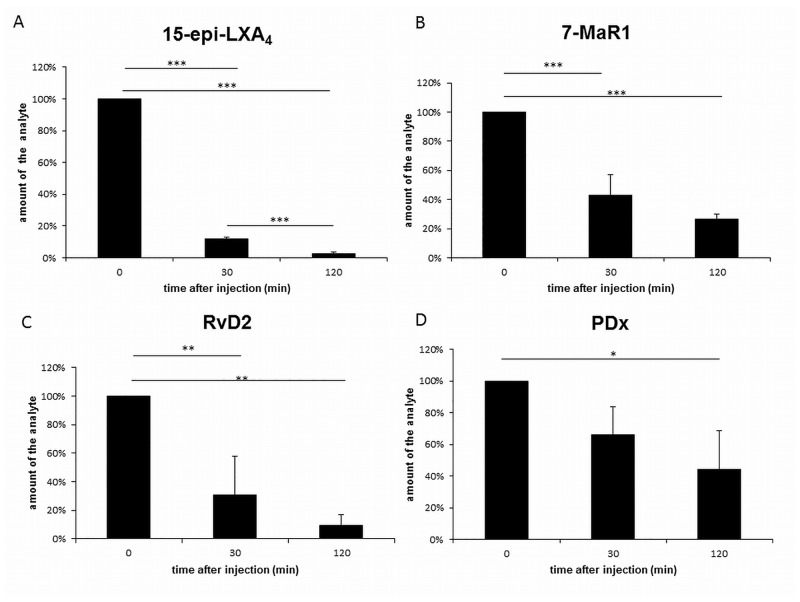

In vivo availability of 15-epi-LXA4, RvD2, PDX and 7-MaR1.Availability of the SPM was determined by their direct analysis, 30 min and 2 h after their subcutaneous injection into the back skin of the mice. The results for 15-epi-LXA4 (A), 7-MaR1 (B), RvD2 (C) and PDX (D) are shown as examples.